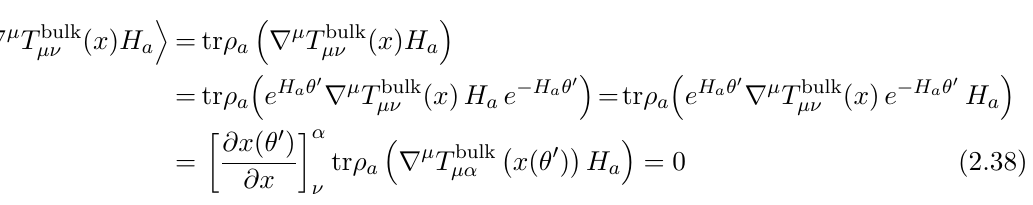
Figure 7 . The UV cut-off tube ∂ B = S (cid:15) modes η of the deformation vector fields are relevant for our 0